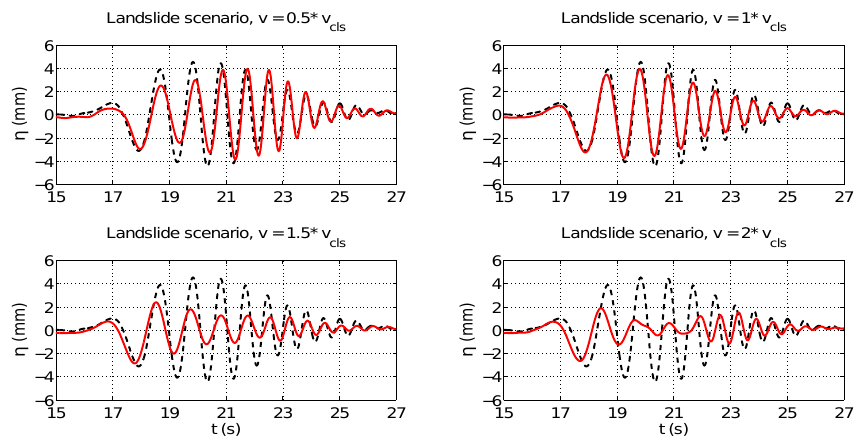
Fig. 8. Tsunami inversion using scenario computations with wrong landslide velocity; inversion from gauge 7S, results checked against records at gauge 24S. Red solid lines refer to numerical results, black dashed lines to experimental time series. v cls is the velocity of the so called correct landslide